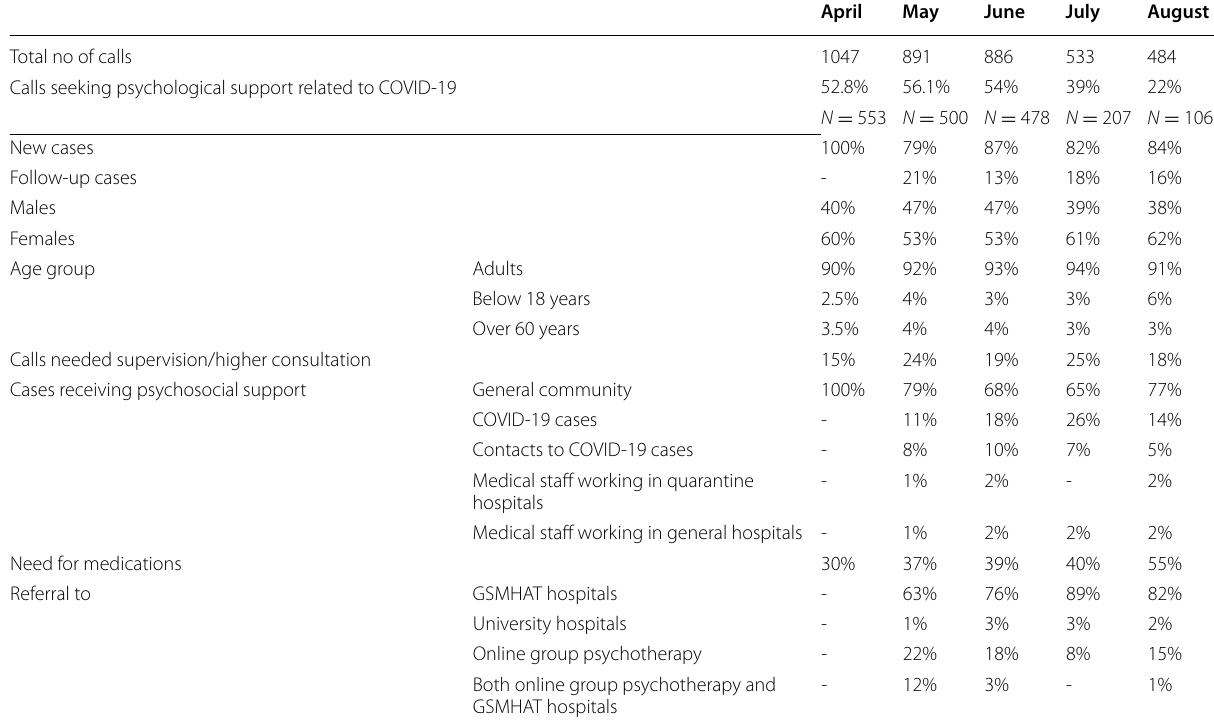
Table 1 Data related to hotline service during the COVID 19